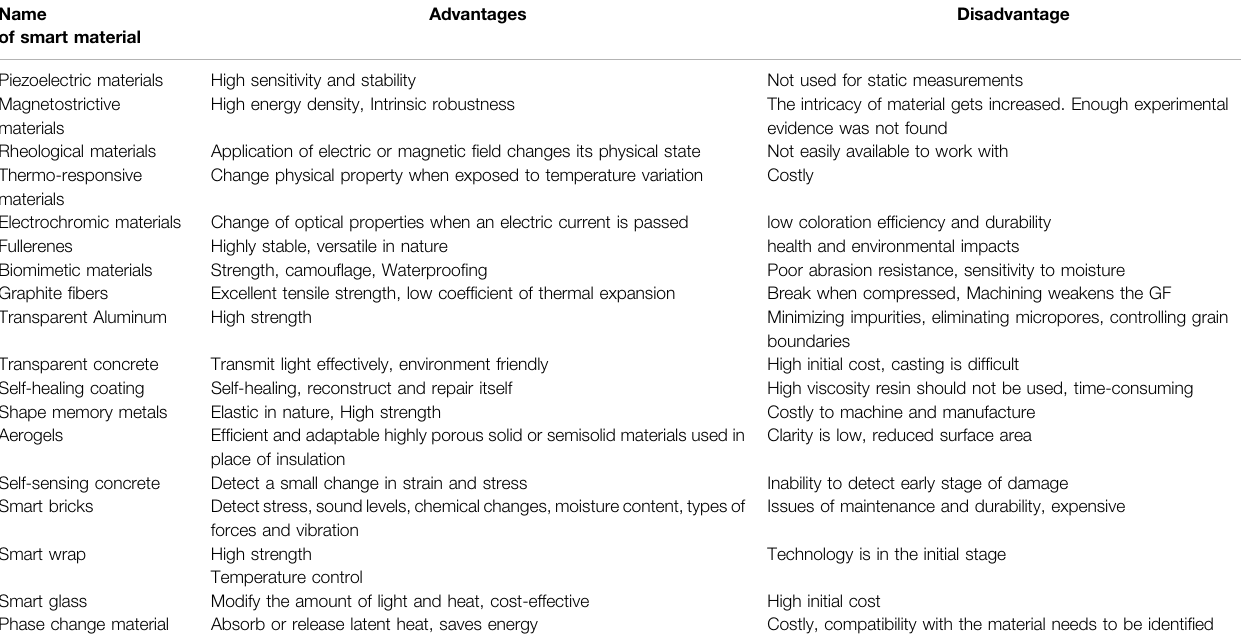
TABLE 5 | Cost bene fi ts of materials for smart greenhouse covers (Mukherjee et al.,